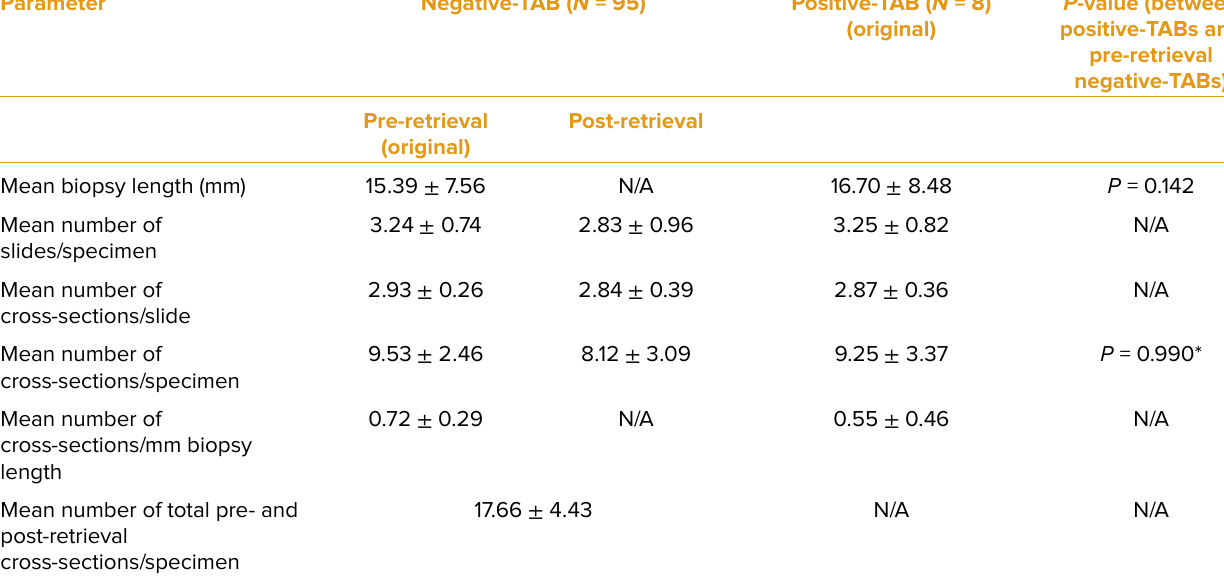
Table 1. Comparison of positive- and negative-TABs (pre- and post-retrieval) Parameter Negative-TAB ( N = 95)